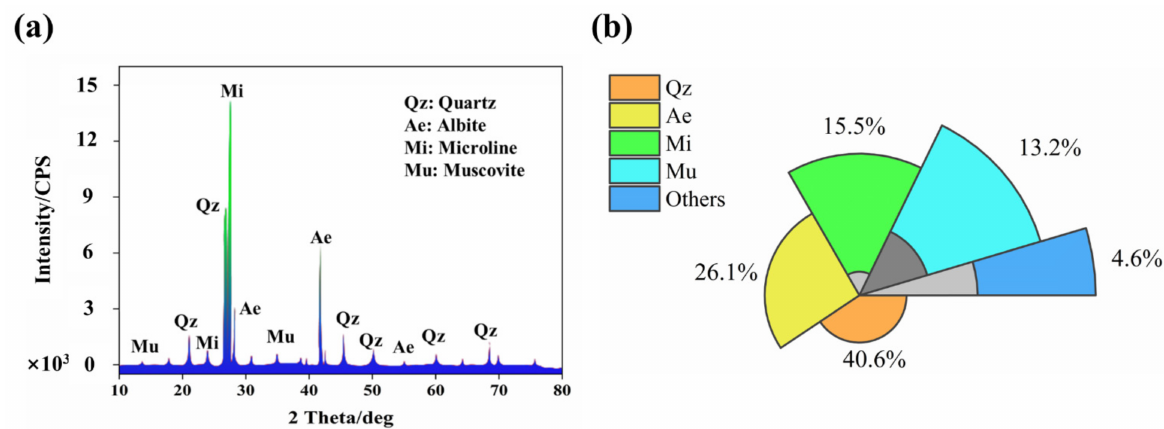
Figure 1. Mineralogical feature of granite: ( a ) XRD patterns; ( b ) proportion of the